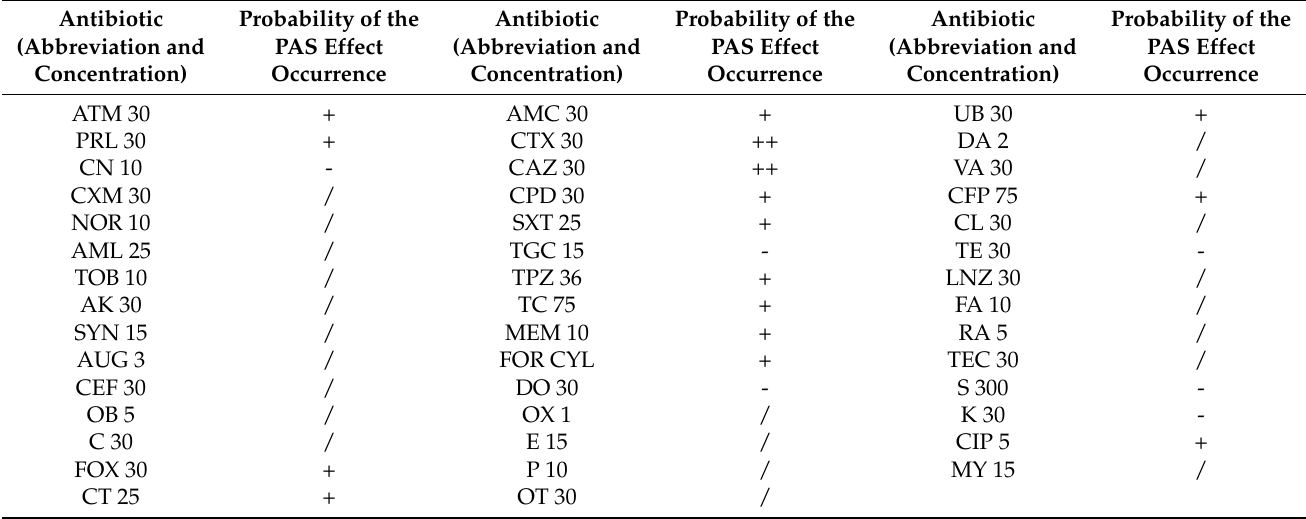
Figure 1. Sample visualization of the occurrence of the PAS effect. Antibiotics classified as demon- strating the potential for the PAS effect (marked with red dots) were characterized as showing larger phage plaques in zones surrounding antibiotic disks where there was a sub-lethal concentration of the drug, compared to the standard T4 5 plaques. A star asterisk indicates plates where the PAS effect was present. Table 1. Antibiotics used in the determination of the occurrence of PAS effect: (++) high possibility of PAS effect occurrence, (+) possibility of PAS effect occurrence, (/) no effect, (-) possible antagonist